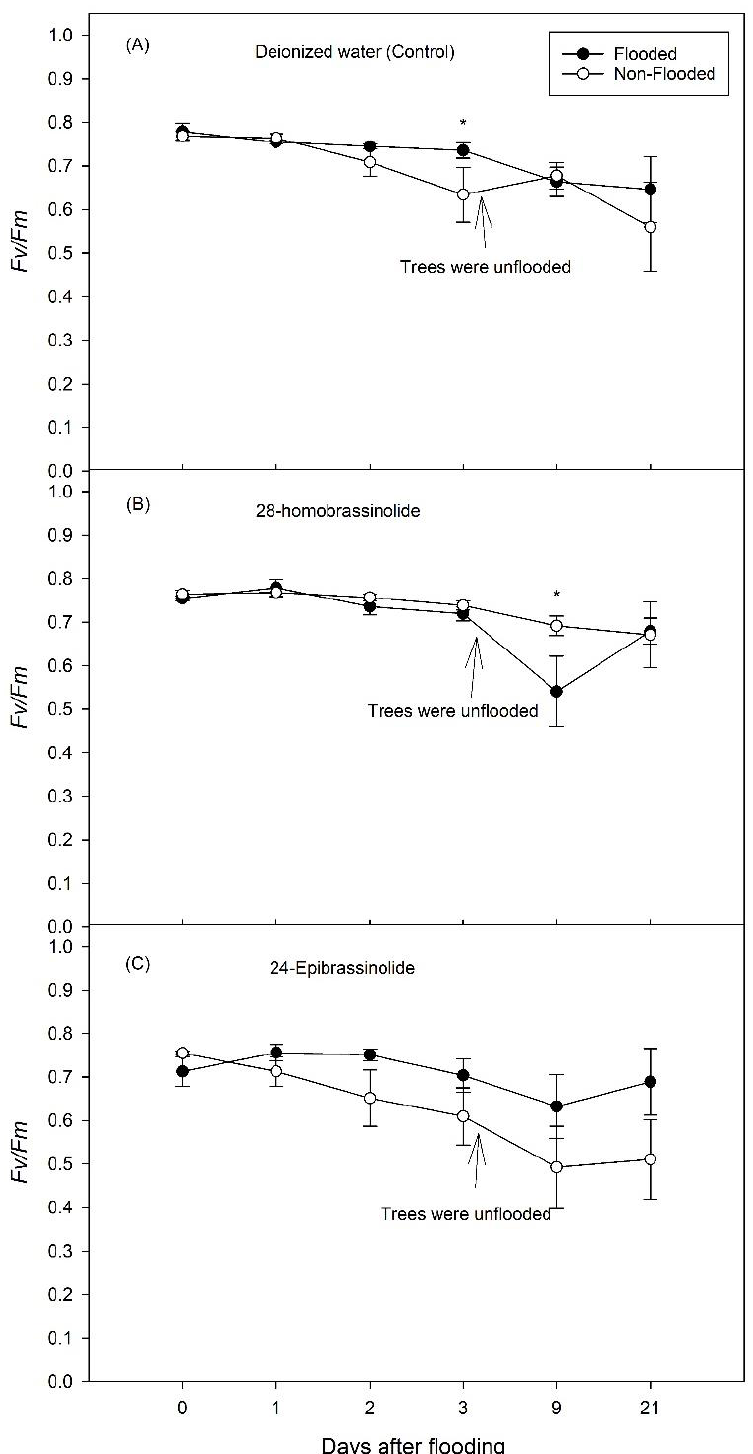
Figure 10. Effect of flooding on the maximum potential quantum efficiency of photosystem II ( Fv/Fm ) of ‘Reed’ avocado trees treated with ( A ) deionized water as a control, ( B ) 28-homobrassinolide, or ( C ) 24-epibrassinolide, (Experiment 2). Symbols and bars indicate means ± std. err. Significant differences ( p ≤ 0.05) between flooding treatments are indicated with an asterisk and were determined by repeated-measures ANOVA. ‘Trees were unflooded’ indicates the day on which trees were removed from the flooding treatment to start the recovery period.